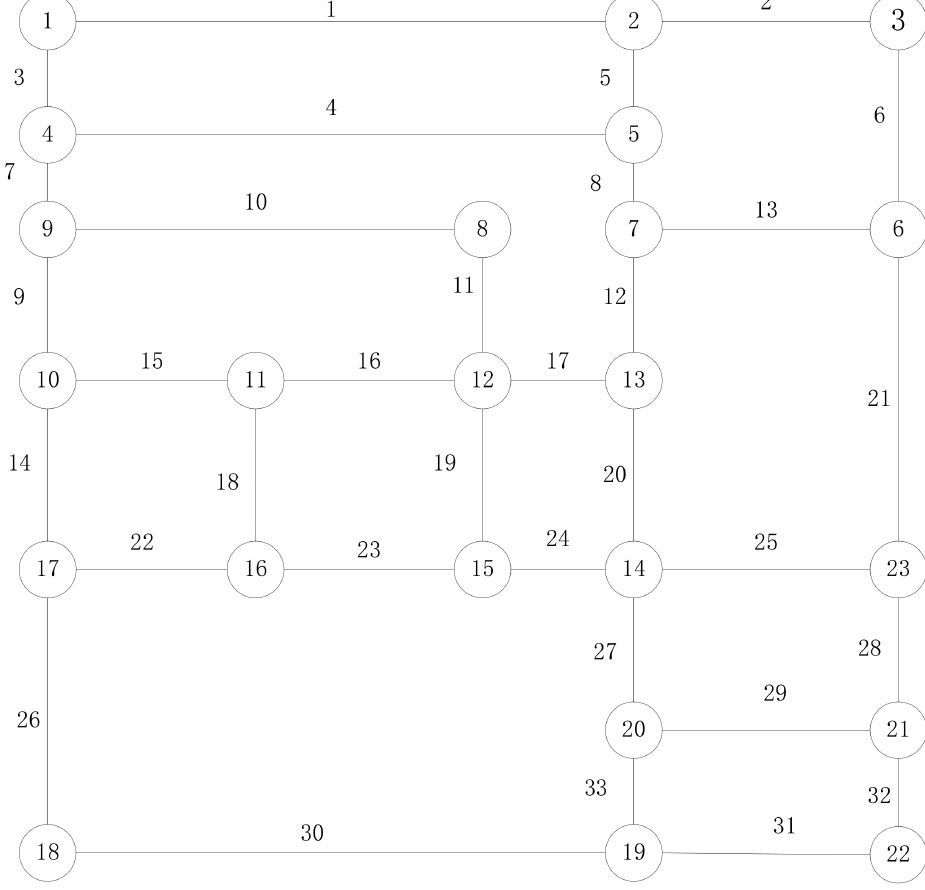
Figure 3. Abstract diagram of road